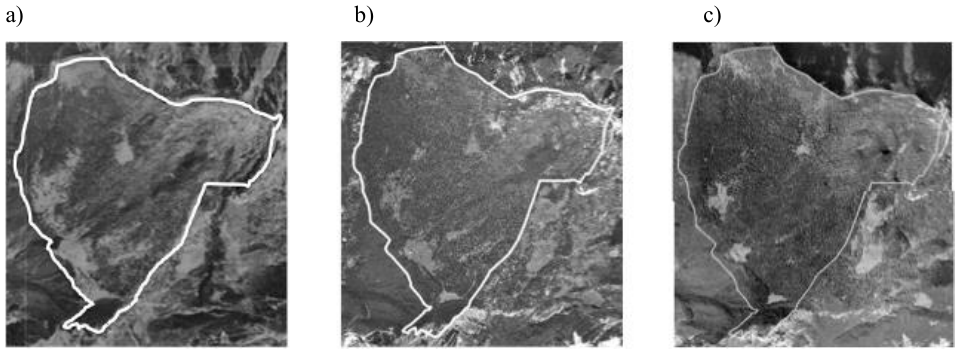
Figure 1. ( a ) The black star indicates the study area in northern Italy. ( b ) Distribution of the capercaillie sampling plots (circle = summer presence–absence surveyed in 2001 and 2011, empty circle = habitat surveyed in 2001, filled circles = habitat surveyed in 2001 and 2011) in the Scanuppia Natura 2000 site (black dashed line) is reported (background: 2008 aerial photo).